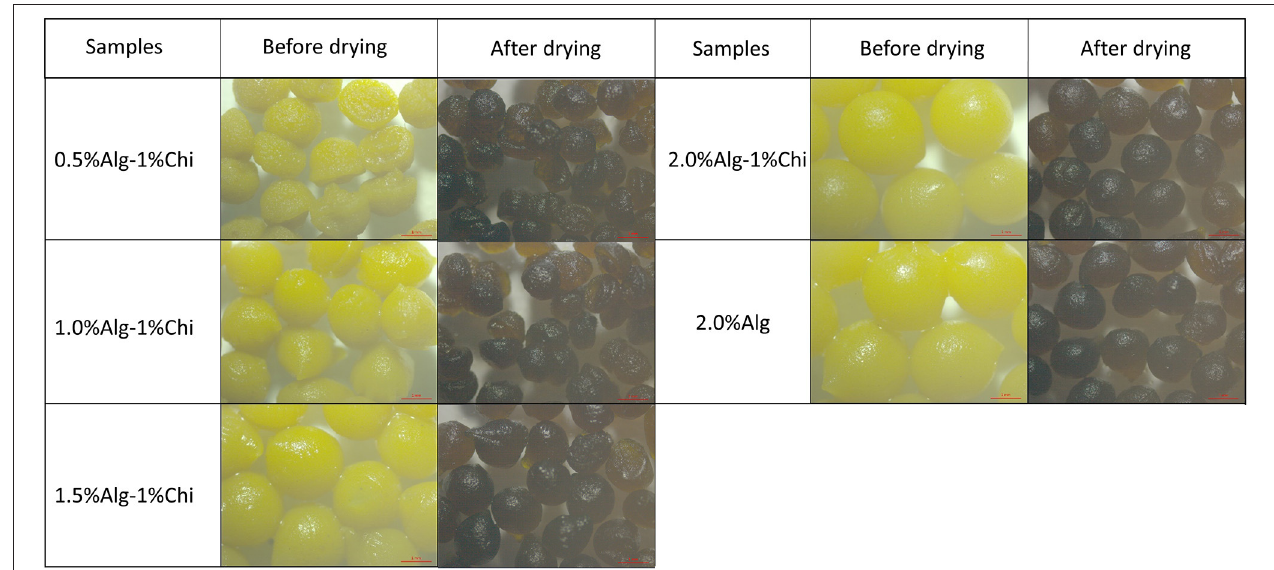
FIGURE 2 | Digital images of wet and dry alginate-chitosan hydrogel beads immobilized Pickering emulsion obtained with different alginate concentrations.